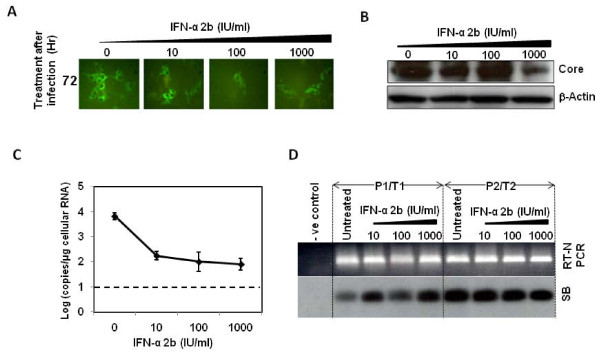
HCV replication in the infected cell culture is resistant to IFN-α. Huh-7 cells were treated with different doses IFN-α 2 b (1000 IU/ml)96 hrs after HCV infection. (A) After 72 hours of treatment HCV levels in the infected cells were examined for HCV-GFP expression under a fluorescence microscope. (B) HCV core protein detection by Western blot analysis and β-actin as loading control. (C) HCV mRNA detection by real-time RT-PCR after IFN-α 2 b treatment with different doses. The HCV mRNA was expressed as log copies per μg of cellular RNA. The dotted line indicates the detection limit of the assay. (D) HCV RNA detection in the multicycle infected cell culture by RT-nested PCR (RT-N PCR) and Southern blot (SB) analysis. The P1/T1 and P2/T2 represents the number of passage of HCV infection and treatment.